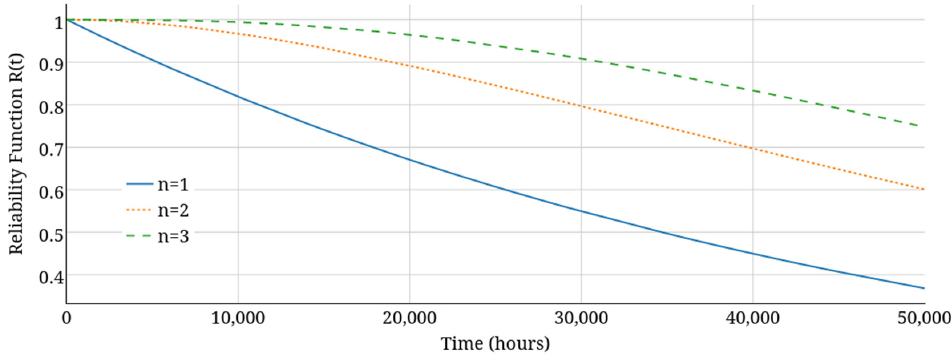
Figure 6. The effect of series redundancy on reliability of NPC.